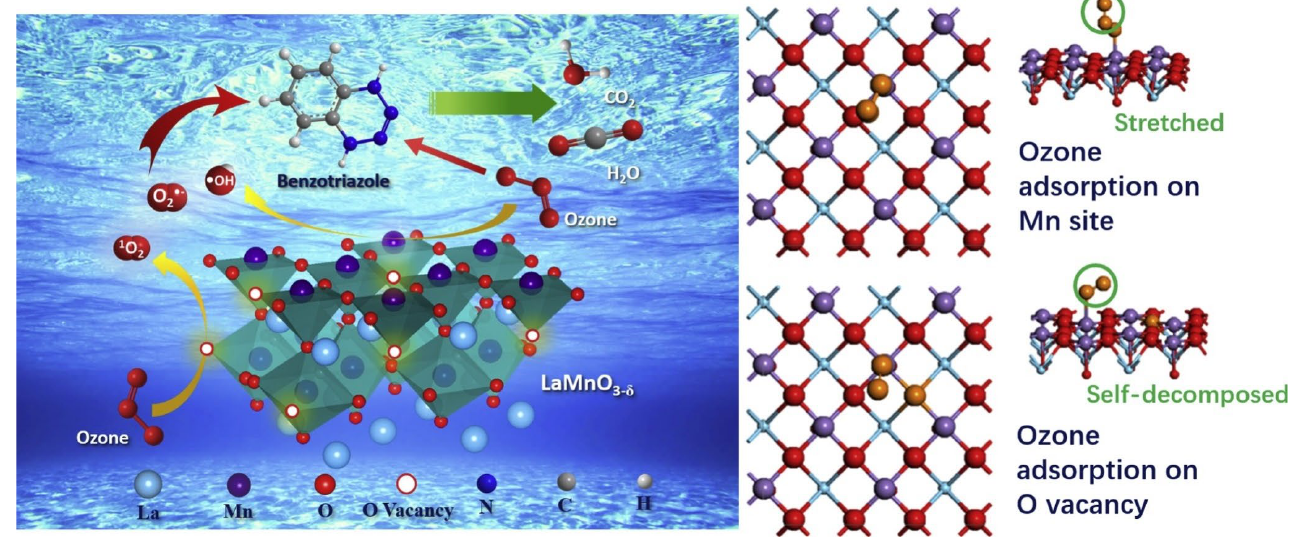
Figure 5. Schematic diagram of LaMnO 3 - δ for ozonation. Reproduced with permission from Ref.